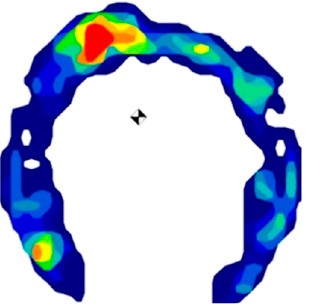
Figure 4. Averaged two-dimensional colour-coded pressure image during midstance. With a colour scale, the different pressure distributions (N/cm 2 ) can be distinguished within the weight-bearing surface of the hoof (see pressure scale on the right side). In this study, data were converted to kilograms.